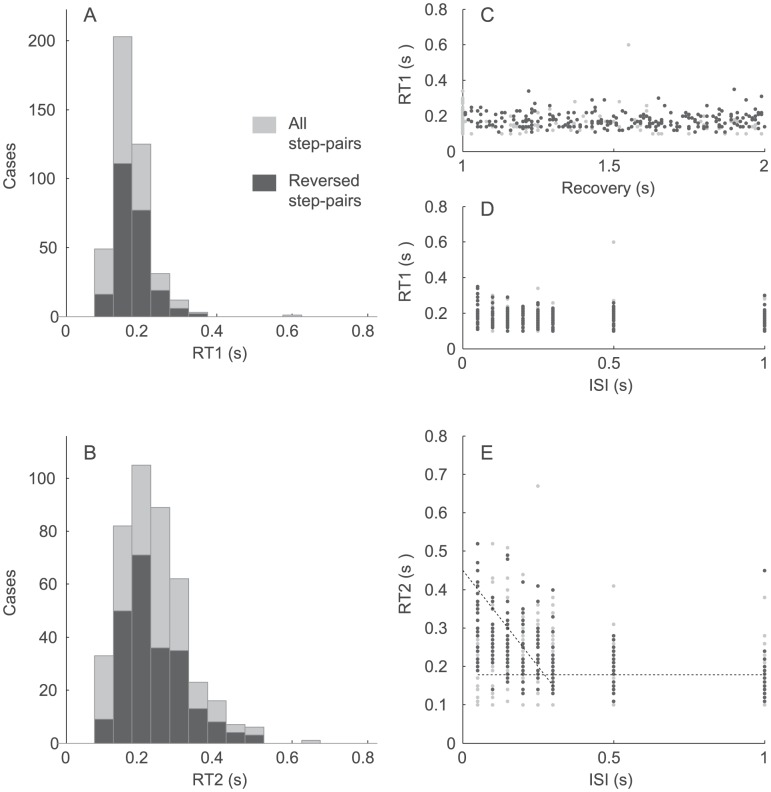
Group results: Distributions.The system condition is Zero Order. Panels A and B show the distribution of RT1 (panel A) and second RT2 (panel B) for all step-pairs (light) and reversed step-pairs only (dark). Panels C and D show individual values of RT1 as a function of the Recovery Period (panel C), and the inter-step interval (ISI, panel D). Panel E shows individual values of RT2 against ISI.